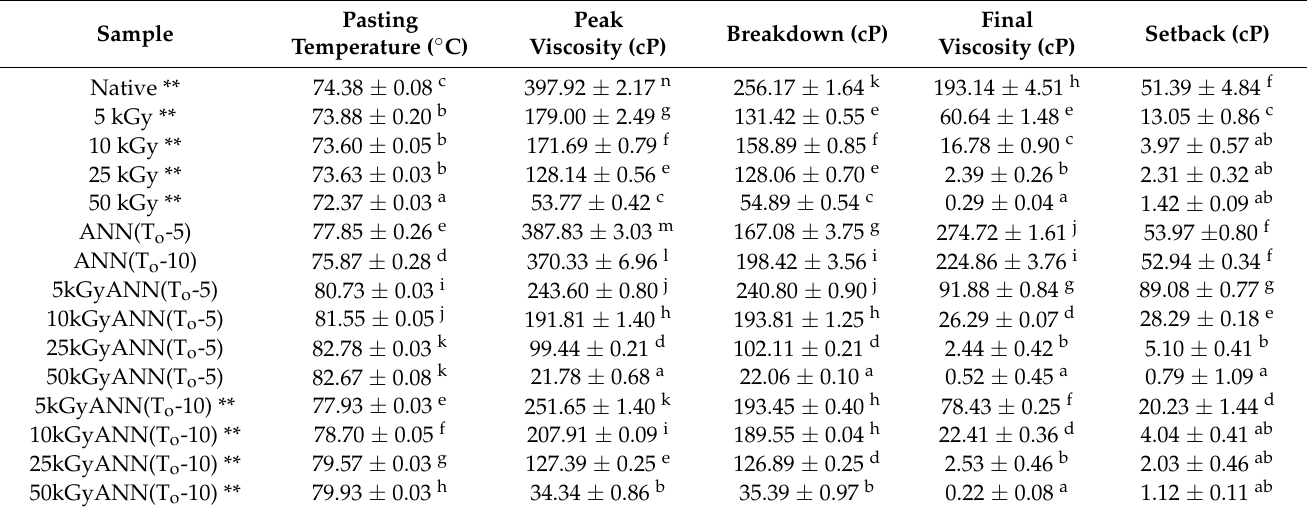
Table 4. Pasting properties of native and modified sago